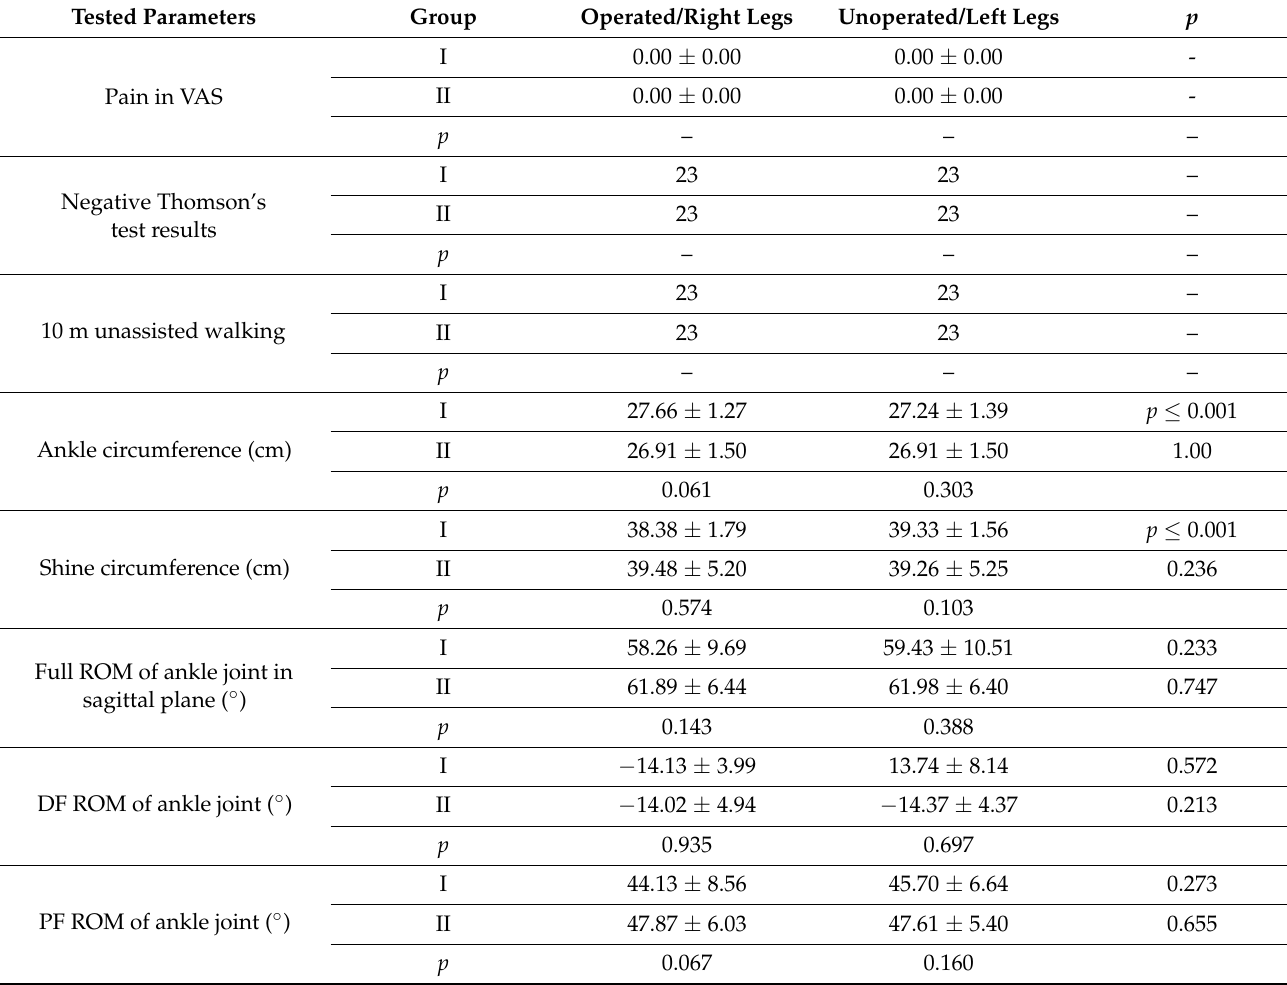
Table 2. Comparison of the between-group and intragroup values corresponding to pain; Thompson’s test results; 10 m unassisted walking; ankle joint and shin circumference; range of motion; full range of motion in sagittal plane, plantar flexion, and dorsiflexion, of the